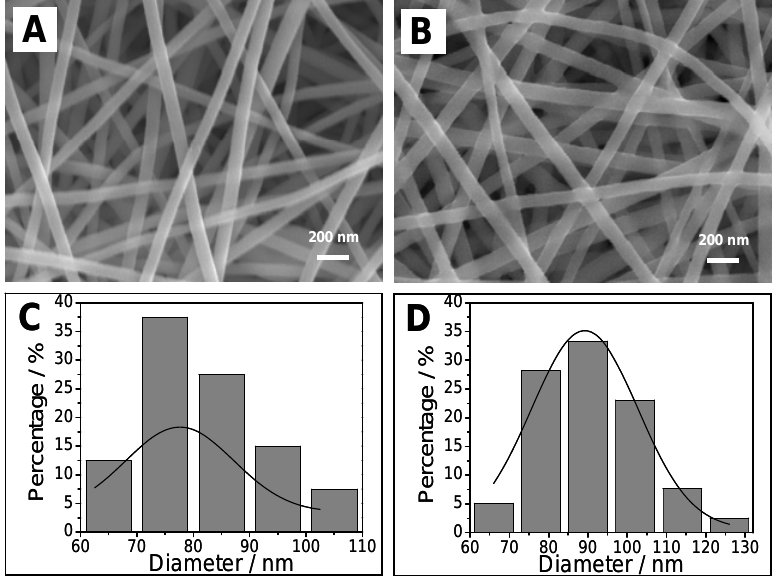
Figure 1. (A) SEM image of electrospun TiO TiO -PEDOT nanocables after the vapor phase polymerization of PEDOT on TiO 2 nanofibers. (C) and (D) Histograms showing the size distribution of TiO TiO -PEDOT nanocables, respectively. 2